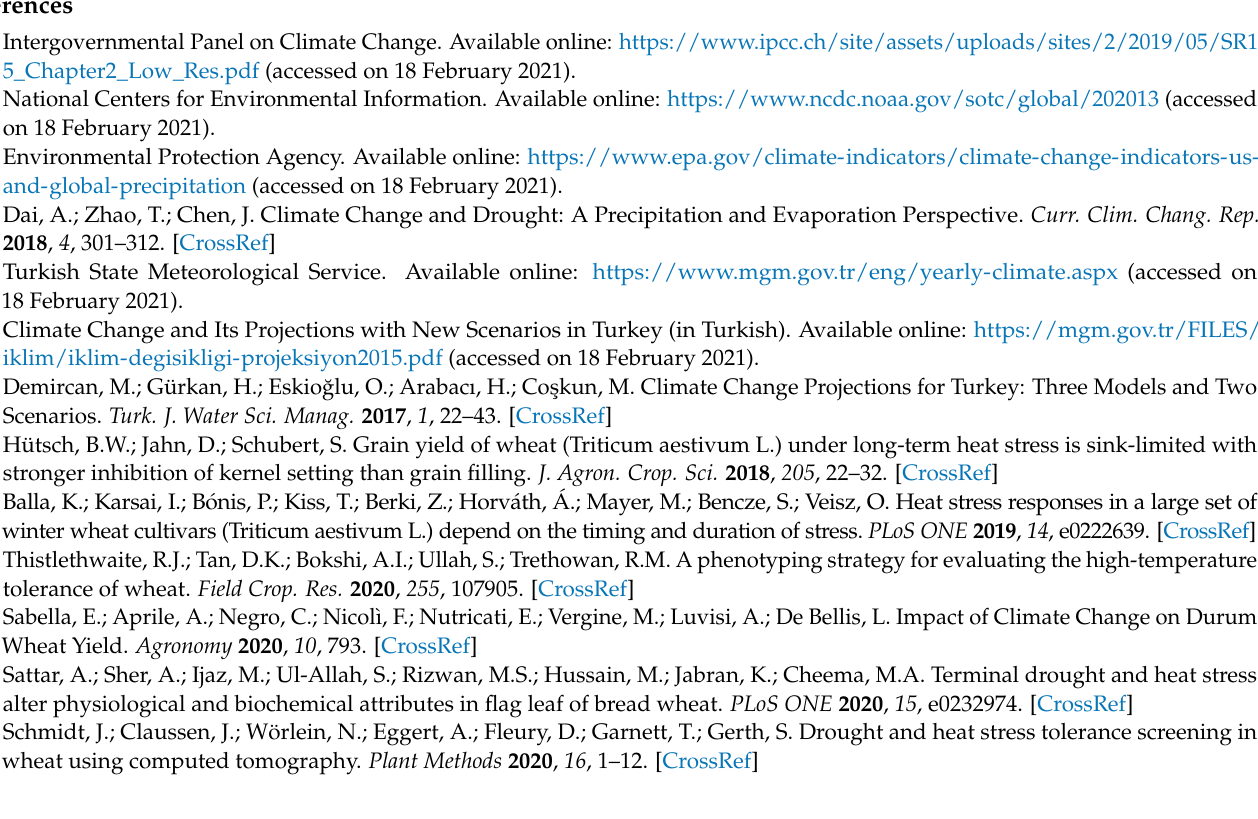
plant characteristics, Figure S3: Dendrogram for plant characteristics, Figure S4: Dendrogram for genotypes, Table S1: Wheat genotypes tested, Table S2: Analyses of variance for plant characteristics, Table S3: Climate data and wheat growth and development